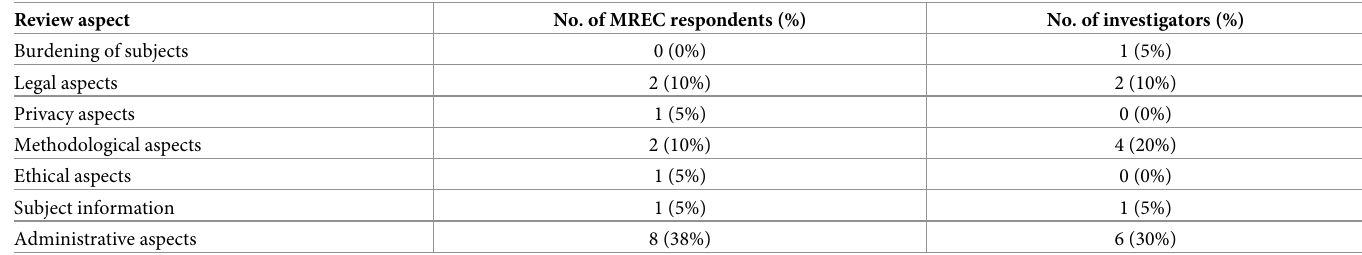
Table 5. No. of respondents that indicated specific aspects were weighted differently in the FTRP compared to the RRP. Review aspect No. of MREC respondents